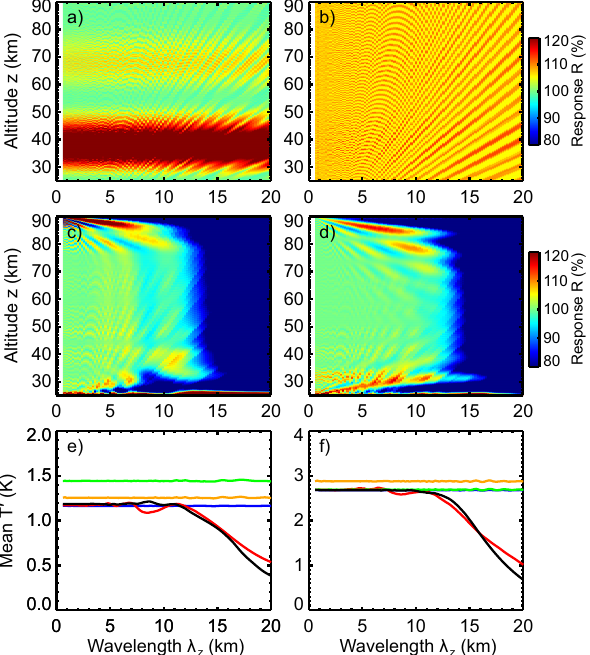
Figure 4. Same as Fig. 2 but with a varying background temperature (see Sect. 3.2 for